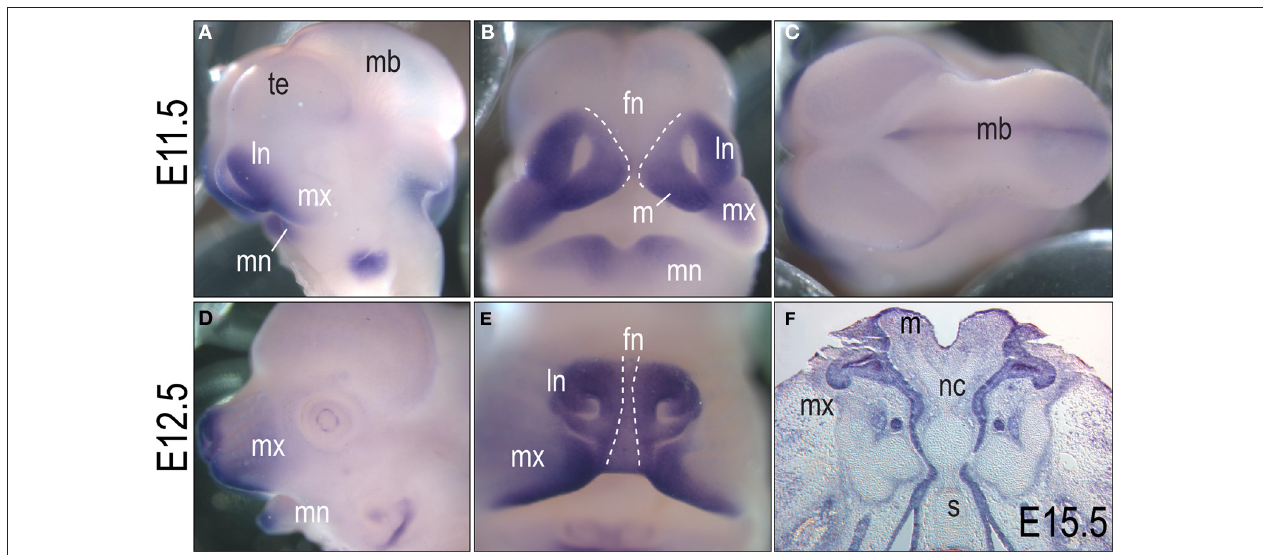
FIGURE 3 | In situ hybridization for Msx1 at E11.5, E12.5 and E15.5 in the developing face. (A) Lateral view of an E11.5 embryo shows Msx1 expression in the maxillary, mandibular, and lateral nasal prominences and in the dorsal portion of the midbrain. (B) Frontal view illustrating that the midline of frontonasal prominence (dashed lines) lacks Msx1 . (C) Dorsal view showing Msx1 expression in the midline of the midbrain. (D) Lateral view at E12.5; Msx1 transcripts are detectable in the maxillary and mandibular